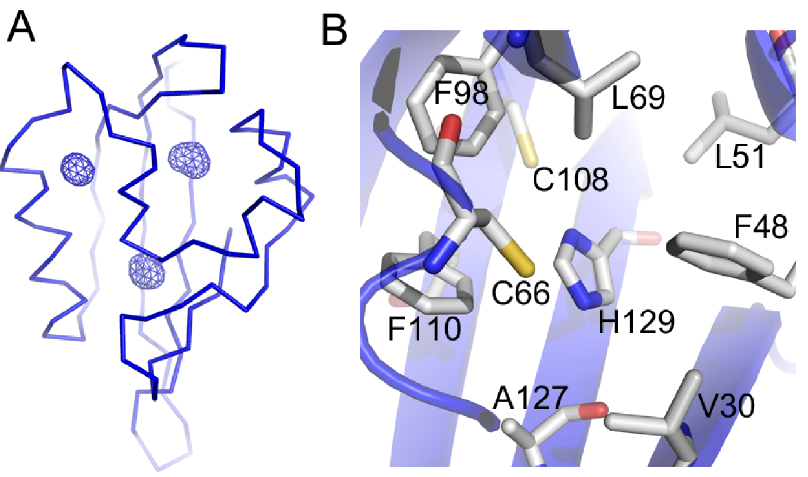
Figure 3. Cavities in the PAS domain from dELK channel. a) C a representation of structure of domain. Cavities detected by CASTp server are shown as blue wireframe representations. b) Histidine 129 and surrounding residues.